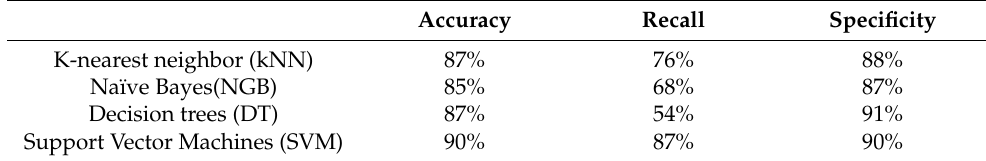
Table 2. Performance of classification model for 5502 signature